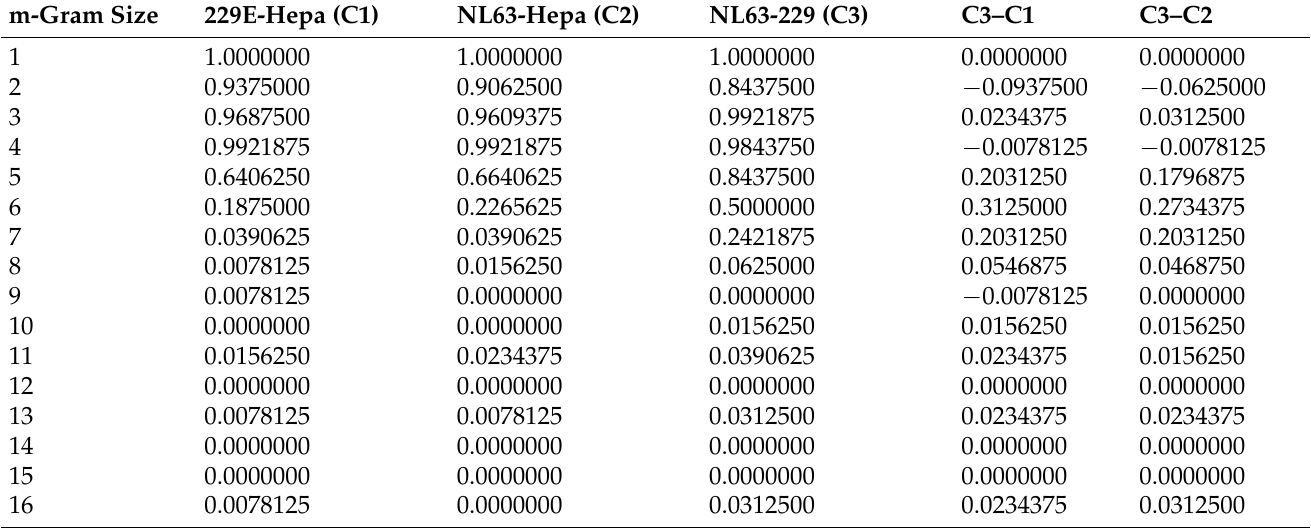
Table 4. Similarity scores (229E-Hepa ( C1 ), NL63-Hepa ( C2 ), and NL63-229 ( C3 )) of the MinHash of the three viruses and the differences of these distances ( C1–C3 and C2–C3 ) using different m-gram sizes.